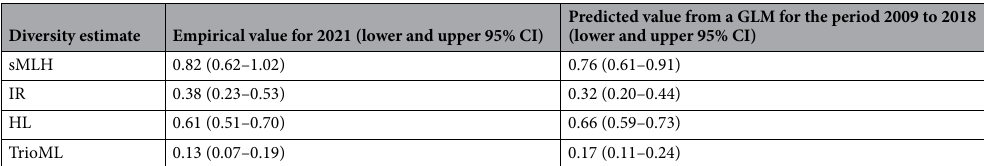
Table 3. Predicted values (from GLMs) of genetic diversity for the 2021 cohort assuming that no genetically informed breeding programme had taken place.